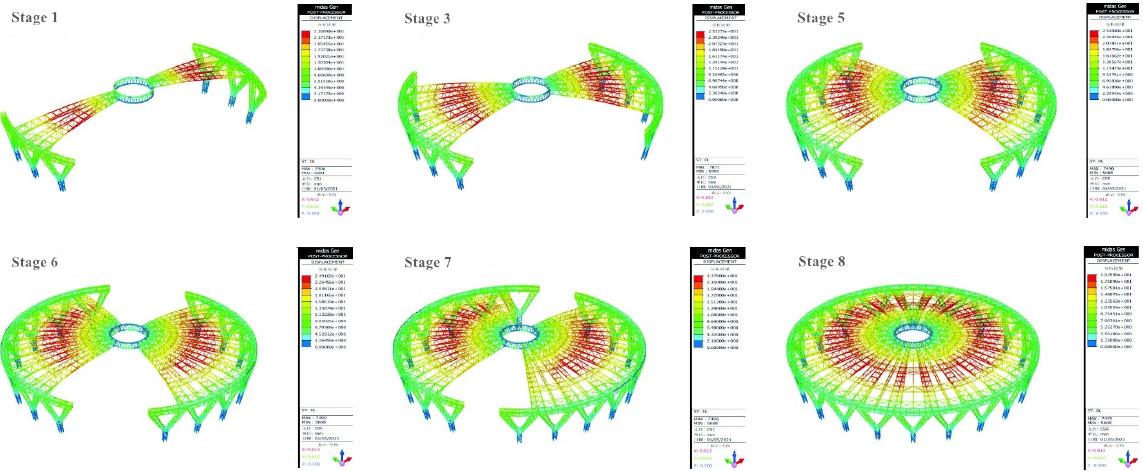
Figure 13. Cloud diagrams for displacement during construction.